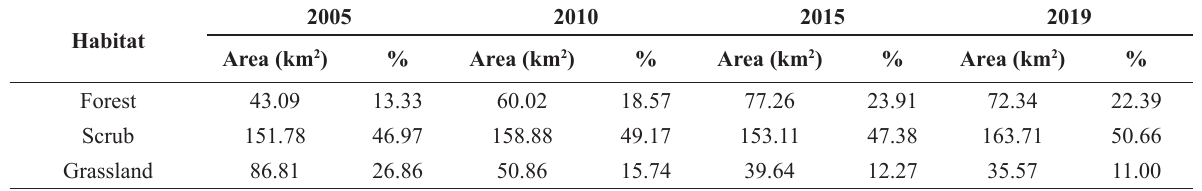
Table 3: Variation in the coverage in terms of extent (km 2 ) and percentage (%), of the selected habitat types during a 14-year period. 2005 Habitat Forest